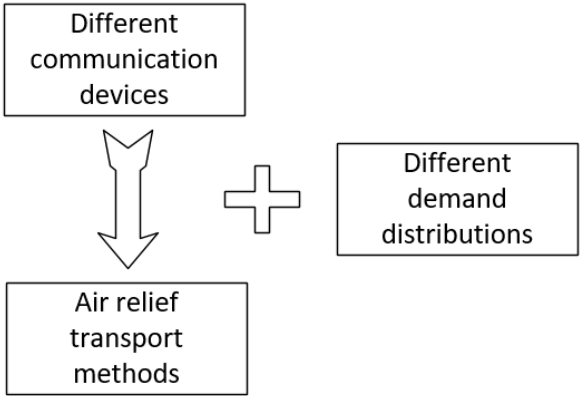
Figure 1. Influencing factors.